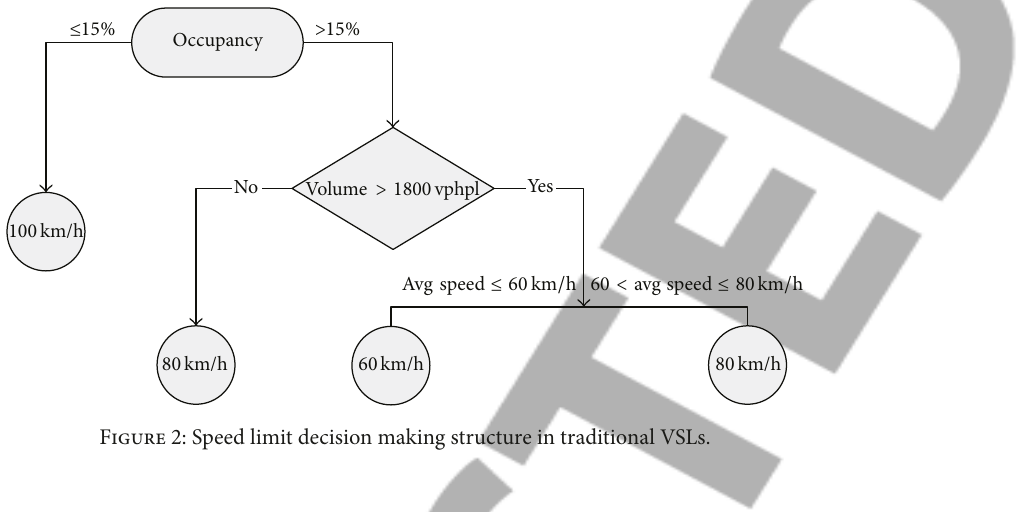
Figure 2: Speed limit decision making structure in traditional